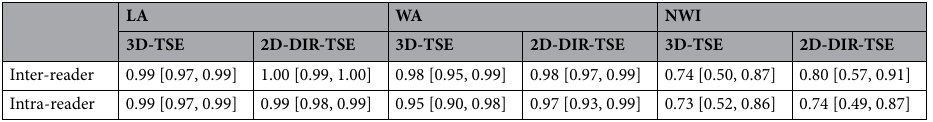
Table 3. The list of intraclass correlation coefficients between area measurement on inter- and intra-reader reproducibility, n = 34. [95% confidence interval]. LA lumen area, WA wall area, NWI normalized wall index.